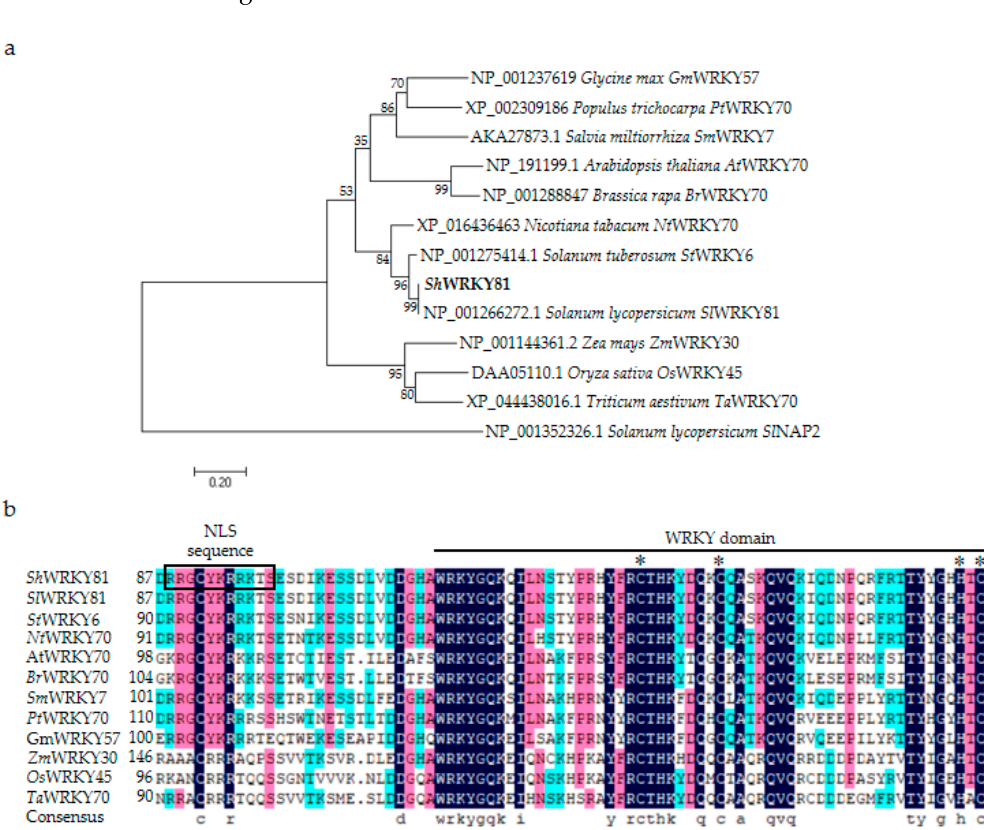
Figure 2. Sequence analysis of the WRKY transcription factor ShWRKY81. ( a ) Phylogenetic tree of ShWRKY81. The NAC transcription factor SlNAP2 was used as an outgroup. The bar shows 0.2 expected amino acid substitutions per site per branch. Amino acid sequences for comparison were from Glycine max GmWRKY57 (NP_001237619), Populus trichocarpa PtWRKY70 (XP_002309186), Salvia miltiorrhiza SmWRKY7 (AKA27873.1), Arabidopsis thaliana AtWRKY70 (NP_191199.1), Brassica rapa BrWRKY70 (NP_001288847), Nicotiana tabacum NtWRKY70 (XP_016436463), Nicotiana tabacum NtWRKY70 (XP_016436463), Solanum tuberosum StWRKY6 (NP_001275414.1), Solanum lycopersicum SlWRKY81 (NP_001266272.1), Zea mays ZmWRKY30 (NP_001144361.2), Oryza sativa OsWRKY45 (DAA05110.1), Triticum aestivum TaWRKY70 (XP_044438016.1), and Solanum lycopersicum SlNAP2 (NP_001352326.1). ( b ) Multiple amino acid sequence alignment of ShWRKY81 with other WRKYs mentioned above. The predicted NLS sequence (aa 88 to 98) and WRKY domain (aa 115 to 169) are marked, and the conserved site of C2HC zinc finger motif is highlighted by a star (*).